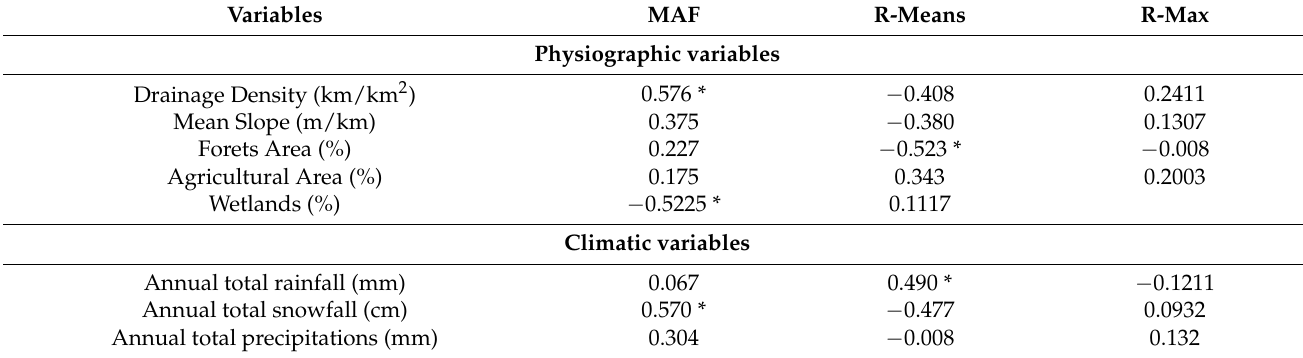
Table 2. Correlation coefficients calculated between physiographic variables and mean annual flows (l/s/km 2 ).